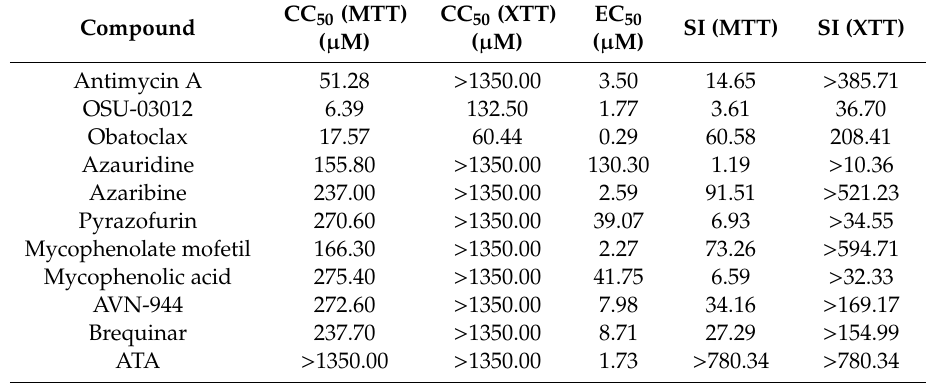
CC 50 (XTT) EC 50 CC 50 (MTT) SI (MTT) SI (XTT) ( µ M) ( µ M) ( µ M)